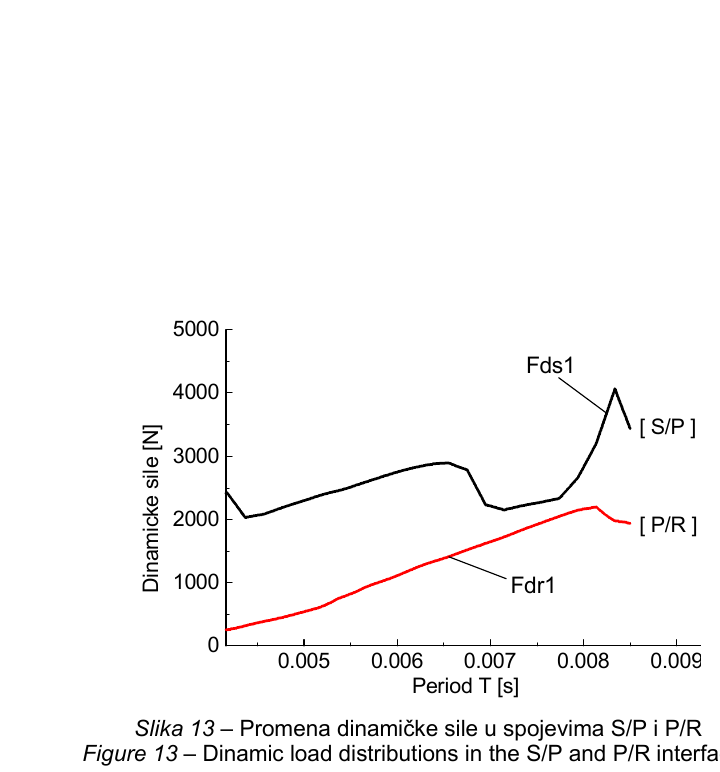
Figure 13 – Dinamic load distributions in the S/P and P/R